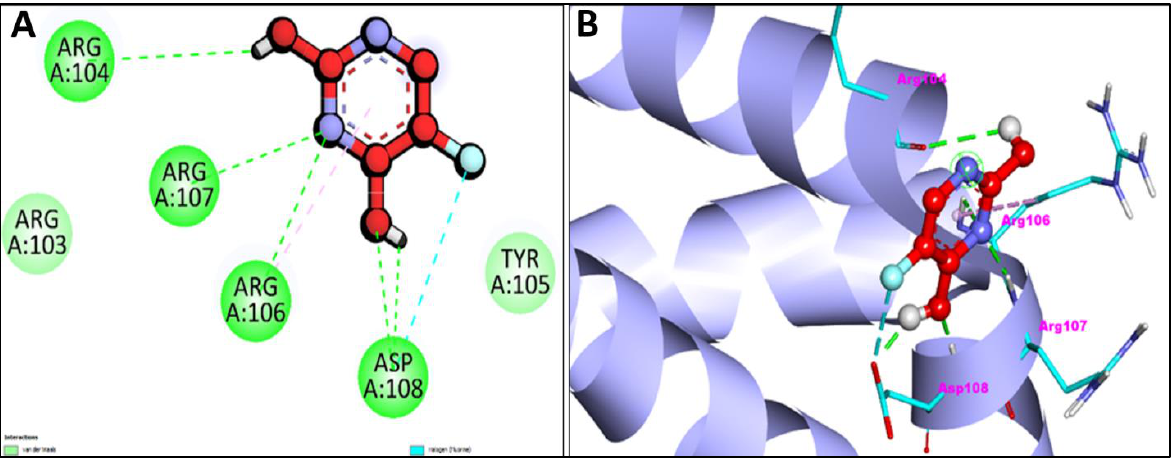
Figure 13. 2D ( A ) and 3D ( B ) representation of interaction of anti-cancerous drug fluorouracil and human Traf2- and Nck- interacting protein Kinase (purple color with ribbon pattern) (PDB:2X7F).